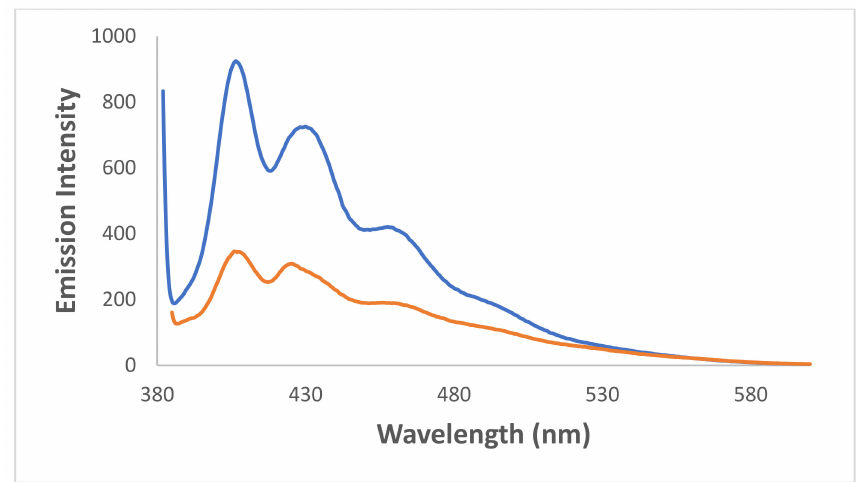
Figure 18. Fluorescence spectra of 6.2 × 10 − 4 M of 2-amino-4-hydroxy-6-(4-hydroxy-2-oxo-2H- chromen-3-yl)nicotinonitrile 4 in toluene fresh and irradiated for 71 min, λ ex = 376 nm.